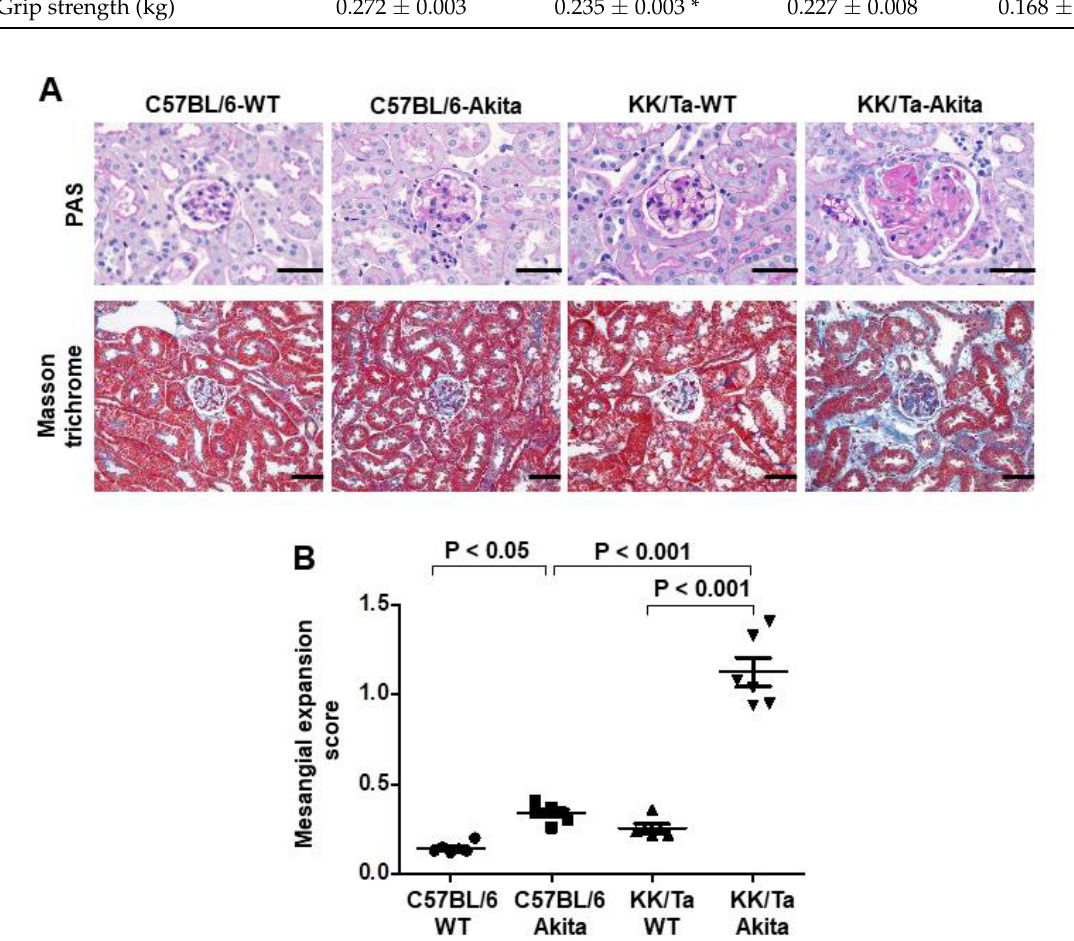
Figure 1. Renal histopathology in C57BL/6-Akita and KK/Ta-Akita mice. ( A ) Representative renal cortical images of PAS and Masson trichrome staining in C57BL/6-WT, C57BL/6-Akita, KK/Ta-WT, and KK/Ta-Akita mice at 15 weeks of age. Bars = 50 μm. ( B ) Glomerular mesangial expansion scores. Data are presented as means ± SEM. n = 6 per group.